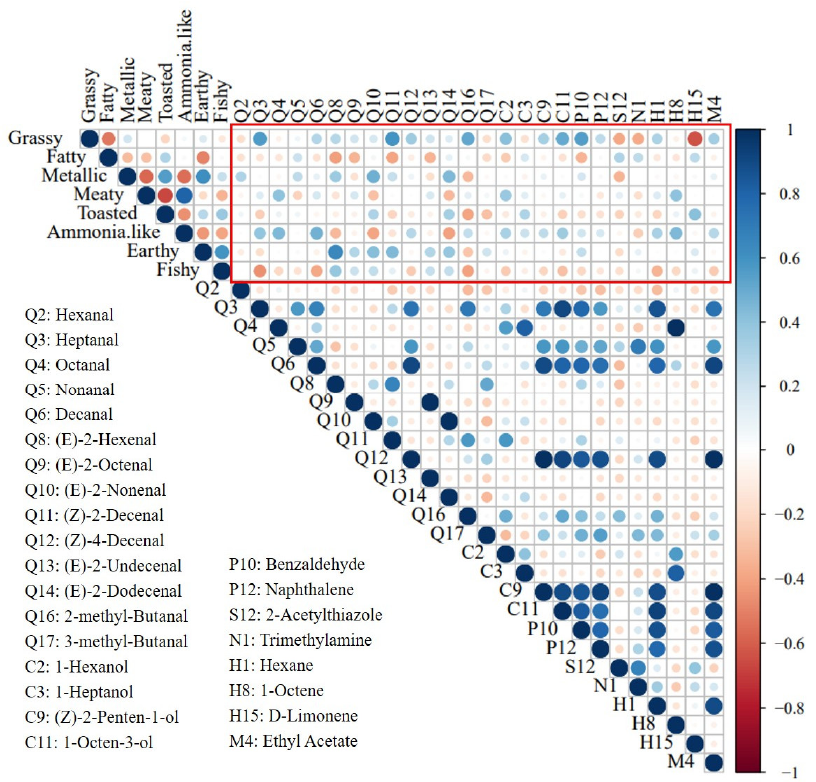
Figure 2. Correlation analysis of volatile compounds and sensory attributes in E. sinensis . The data in the figure are active odor compounds identified as OAV > 10 from the three origins. Positive correlations are marked in blue, negative in red, and the correlations enhance with the deepening of the color.